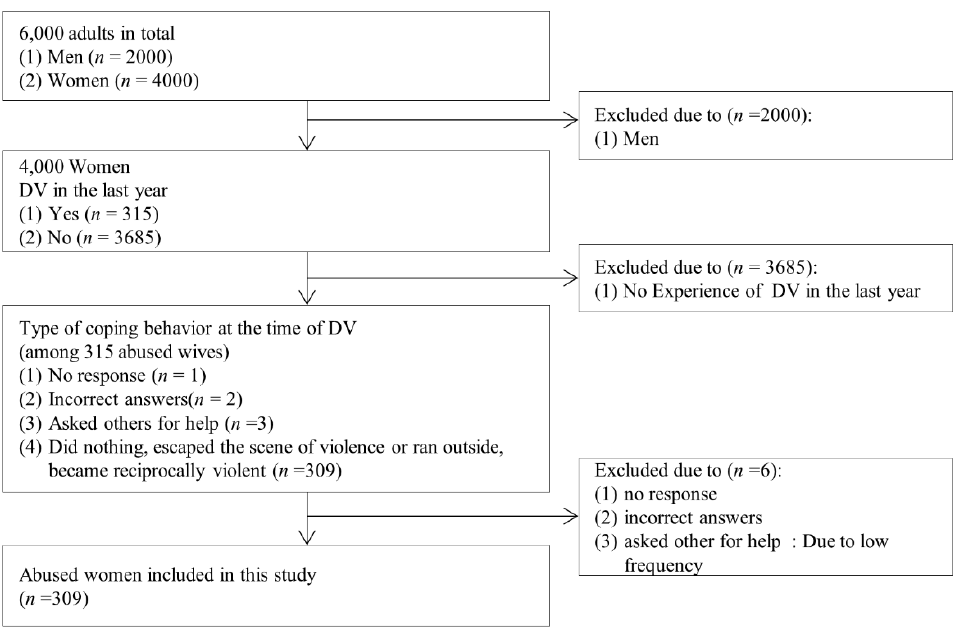
Figure 2. Flow diagram of the study sample. DV-Domestic Violence.